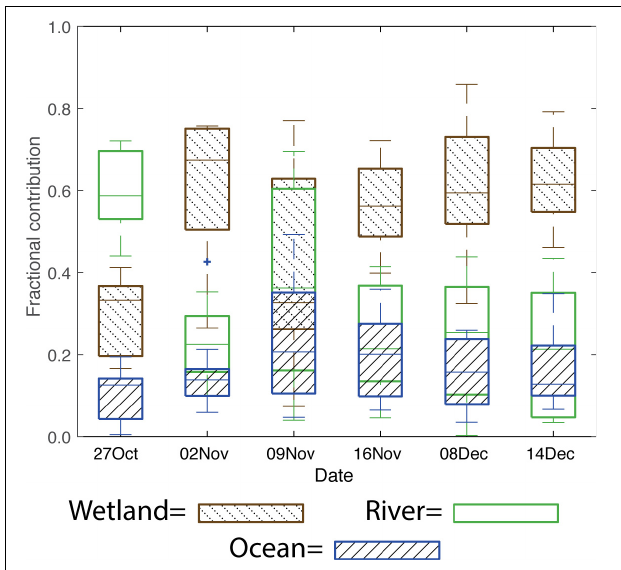
FIGURE 7 | Best fit calculated f w , f r and f s for the entire PS in October through December 2016. Colored line is median, lower and upper extent of box refers to 25th and 75th percentiles, respectively, the whiskers on ends of box are range of samples, not considered outliers, and colored (+) are outliers.